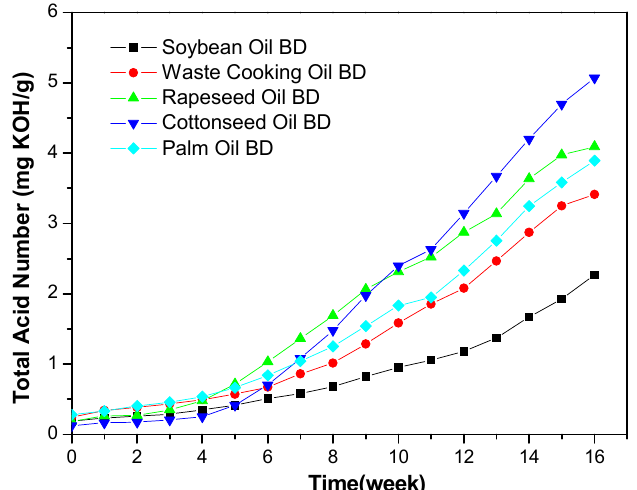
Figure 3. Change in total acid number (TAN) values of BDs during accelerated oxidation.